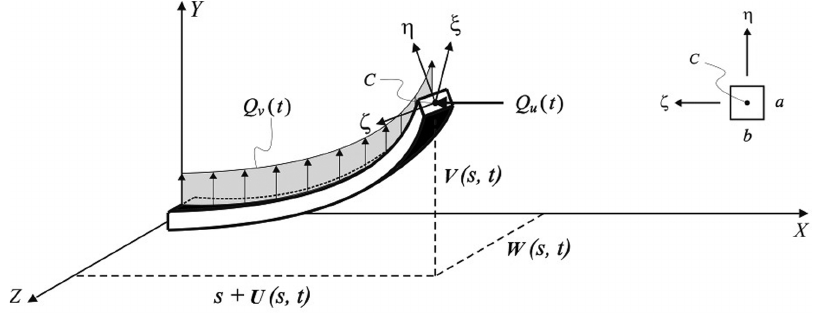
Fig. 1. Coordinate systems, displacements, loading and beam cross